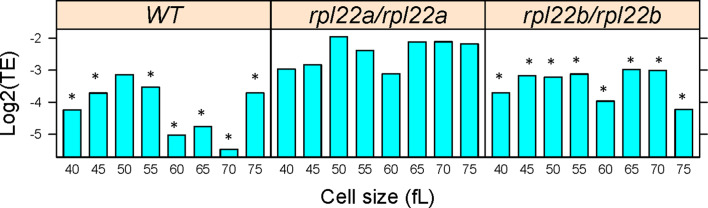
The translational efficiency of GCN4 is de-repressed in cells lacking Rpl22Ap.The Log2-tranformed ratio of the TPM values for the ribosome footprints ((ribo) against the corresponding values for the mRNA reads (rna) define the translational efficiency of GCN4 (y-axis), for each of the cell sizes we queried (x-axis), in the strains shown. Asterisks indicate that the translational efficiency was significantly reduced (FDR < 0.05) compared to other mRNAs in that strain (based on the babel ‘combined’ output).